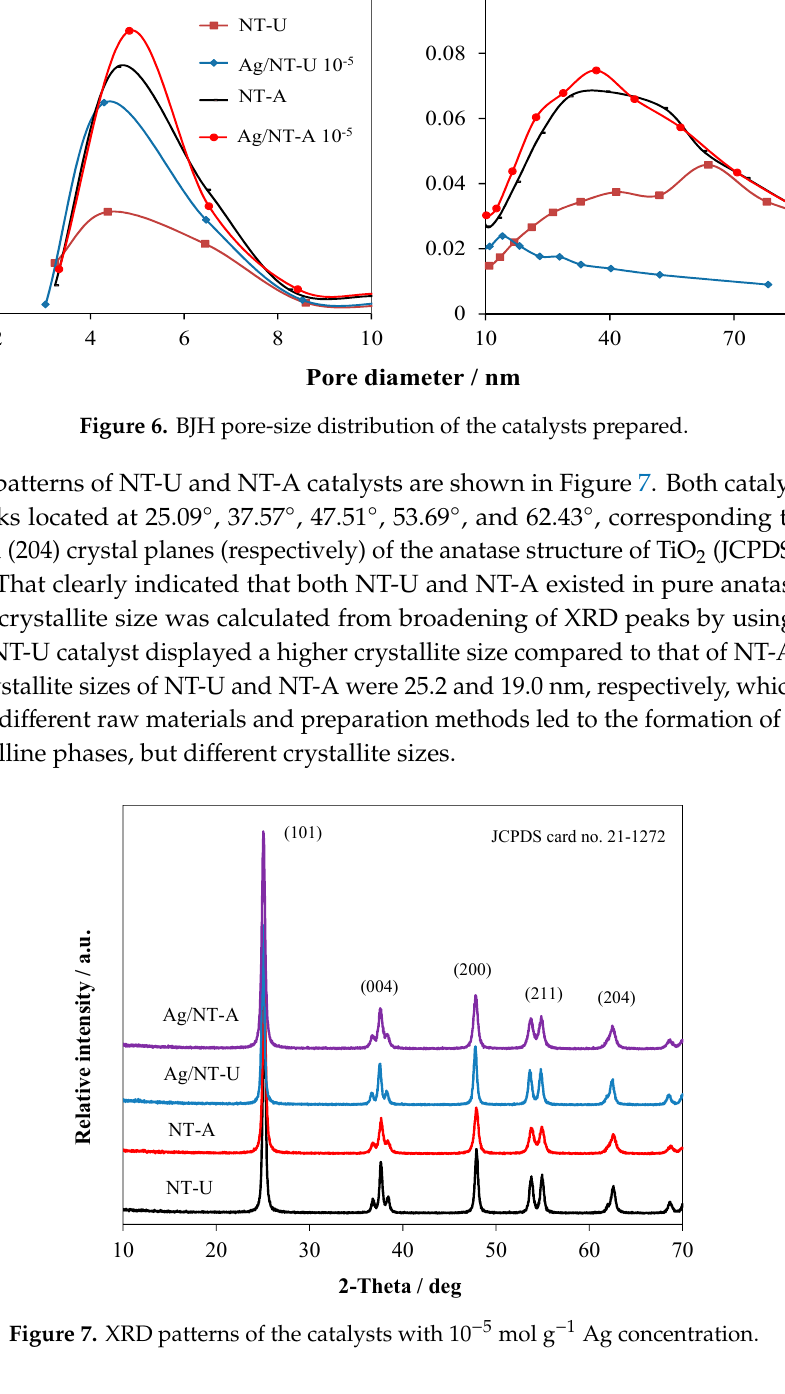
Figure 7. XRD patterns of the catalysts with 10 − 5 mol g − 1 Ag concentration.